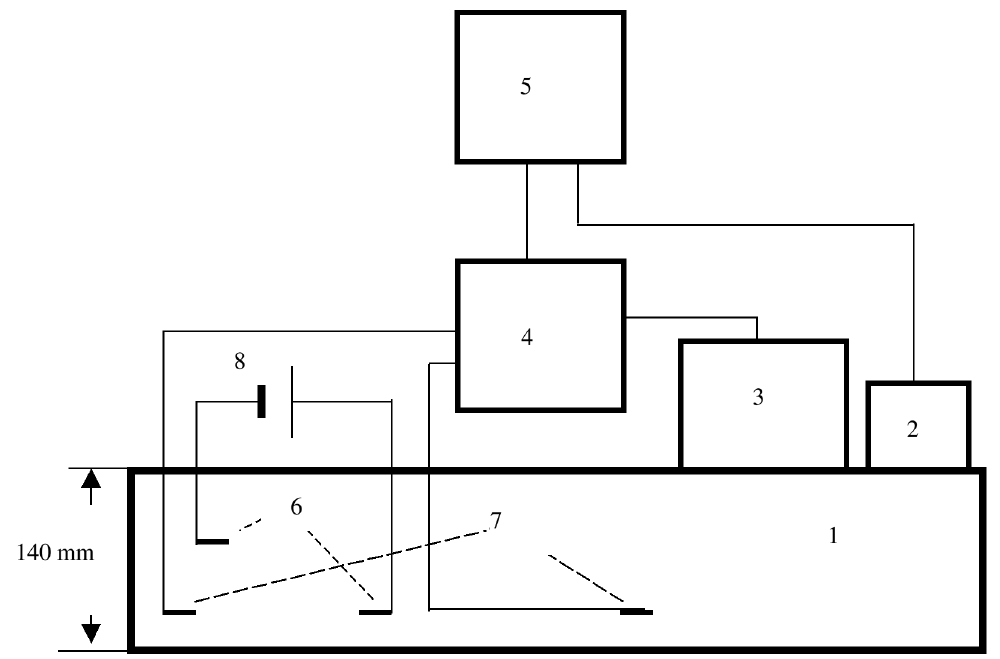
Fig. 3. The scheme of the self-oscillator (MSO) of the first type ( S - E ): 1 – sample (box with sand); 2 – meas- uring transducer; 3 – emitting piezoelectric transducer; 4 – electronic unit; 5 – recording device; 6 – additional electrodes; 7 – measuring electrodes; 8 – source of constant